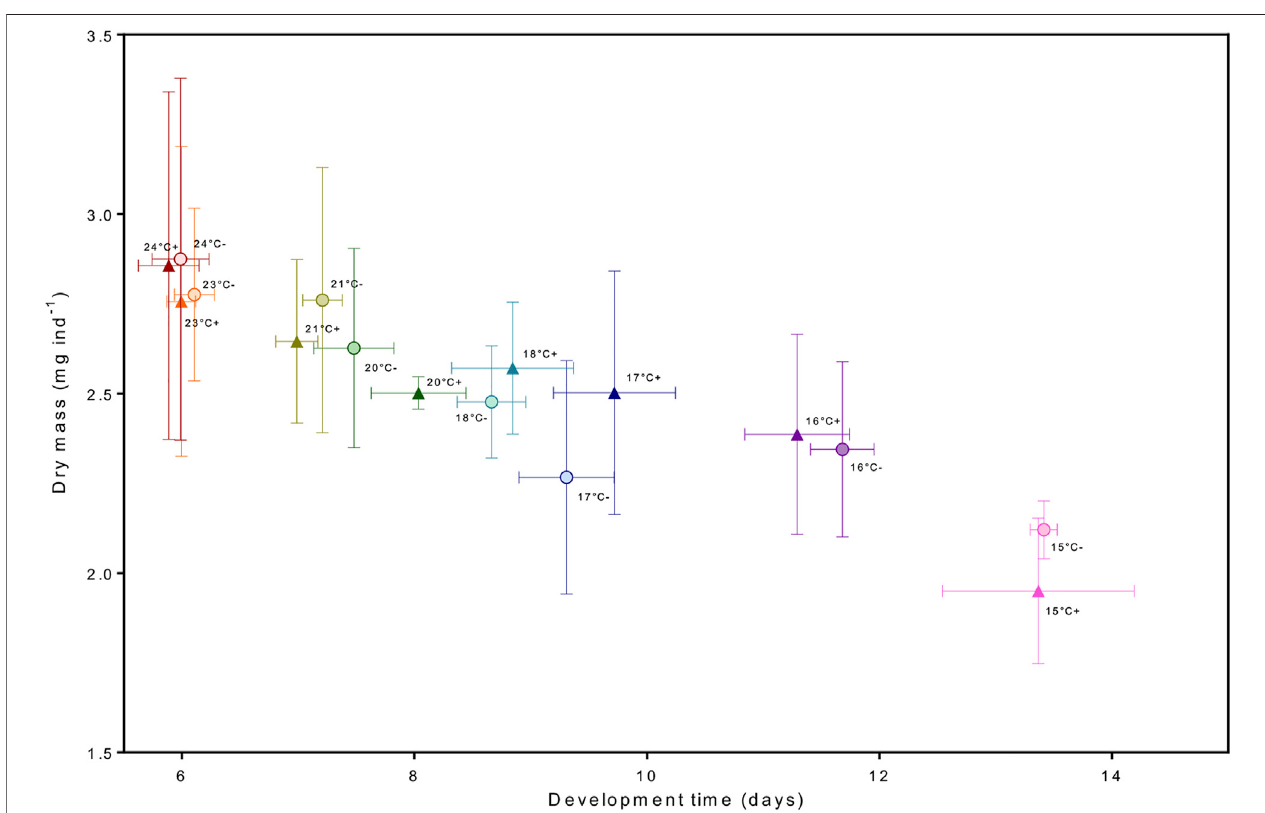
FIGURE 8 | Integrated response between development time and drymass. The circle and ( − ) sign represent the moderate p CO 2 treatment and the triangle and (+) sign the high p CO 2 treatment.